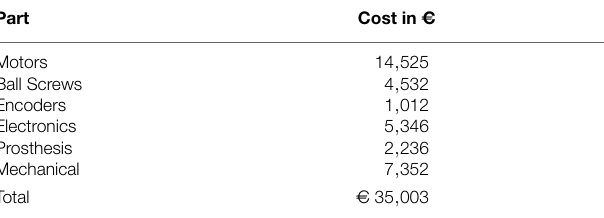
TABLE 3 | Total cost of the humanoid Herbert . Part Cost in A